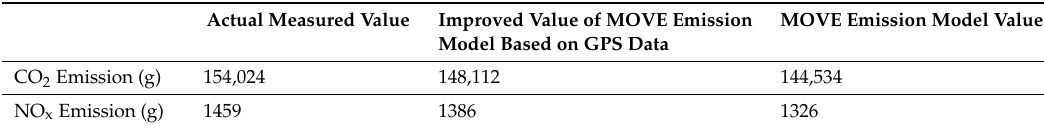
Table 6. The exhaust emissions obtained by the three